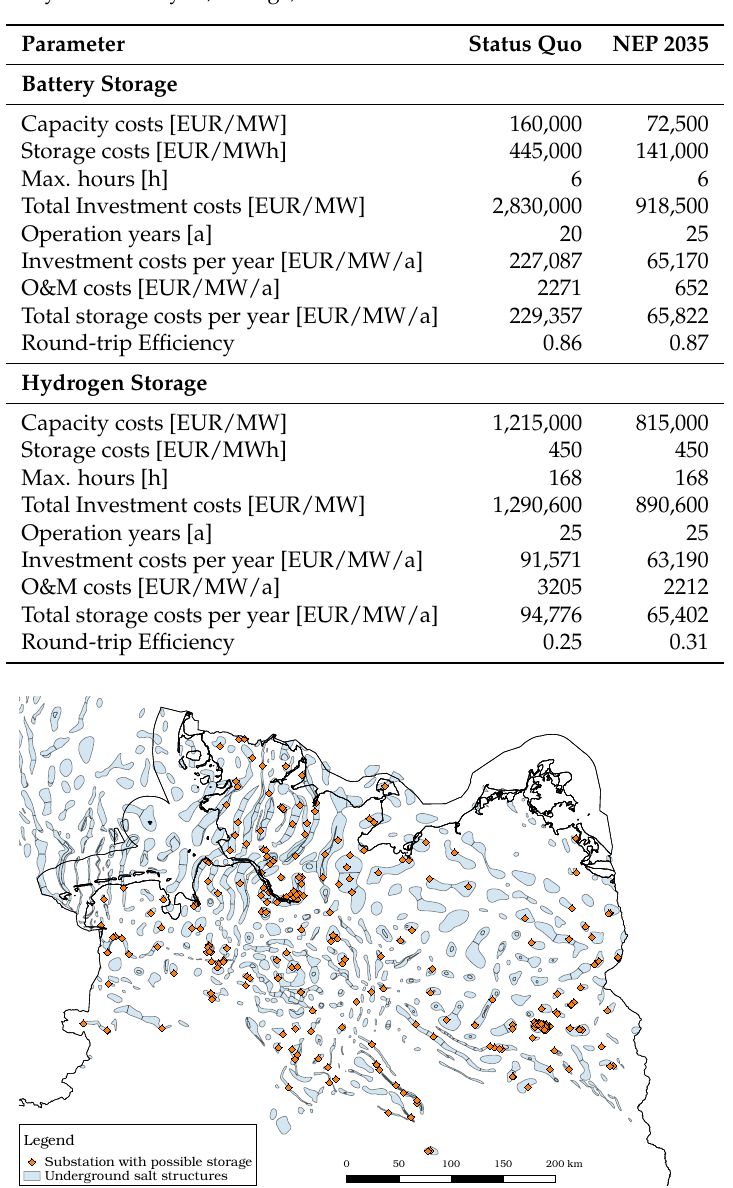
Table 1. Storage parameters for battery and hydrogen storage units for the scenarios status quo and NEP 2035 based on [39]. The indicated parameters represent complete power-to-power cycles, i.e., costs and efficiency for electrolysis, storage, and fuel cell.